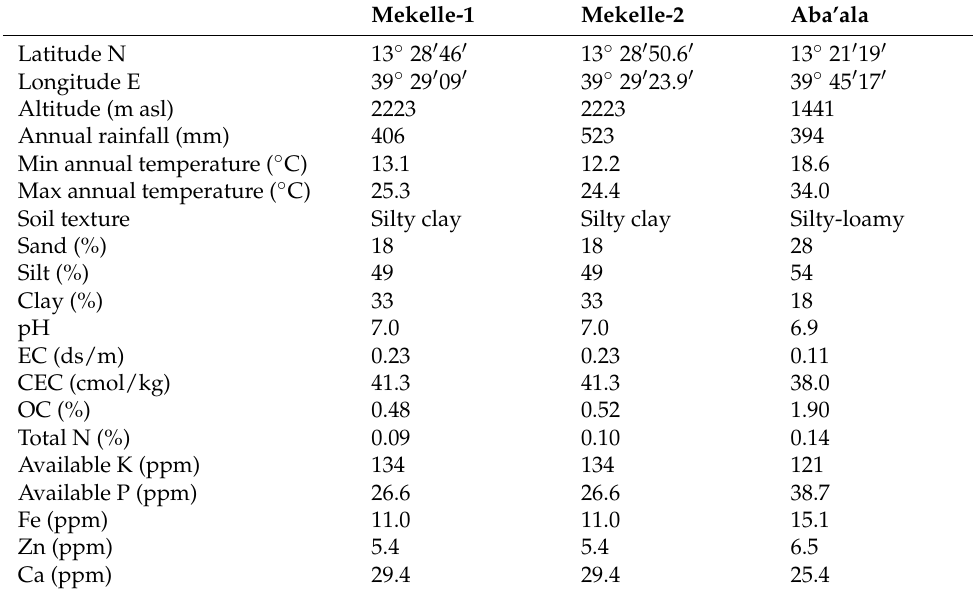
Table 1. Main features of the study